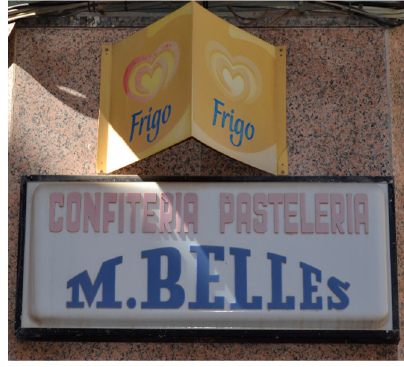
Figure 25. Benasal: Spanish-only sign on a confectionery and candy store.